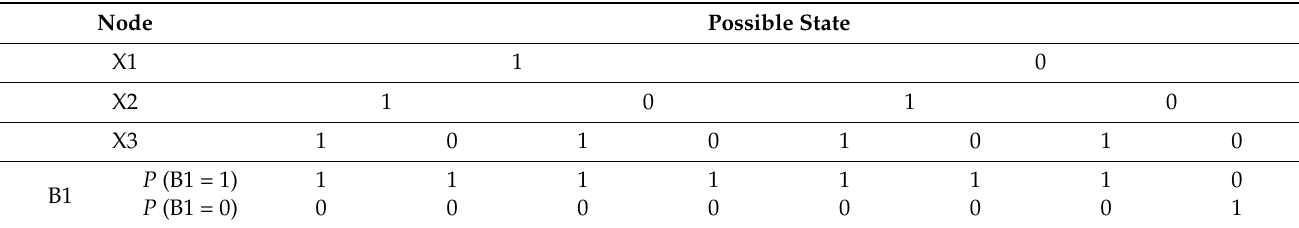
Table 4. Example of “OR gate” conditional